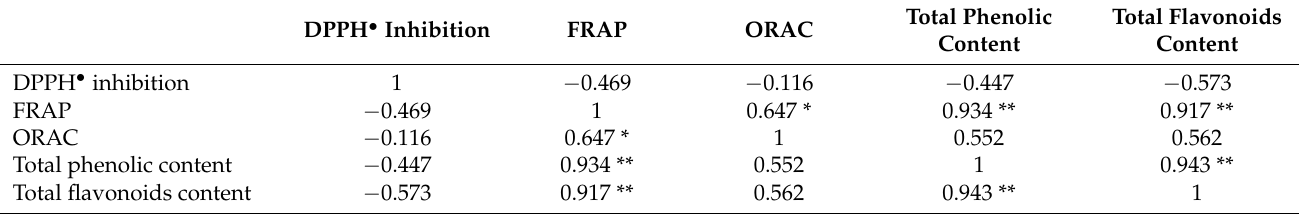
Table 6. Pearson correlations obtained between the different spectrophotometric